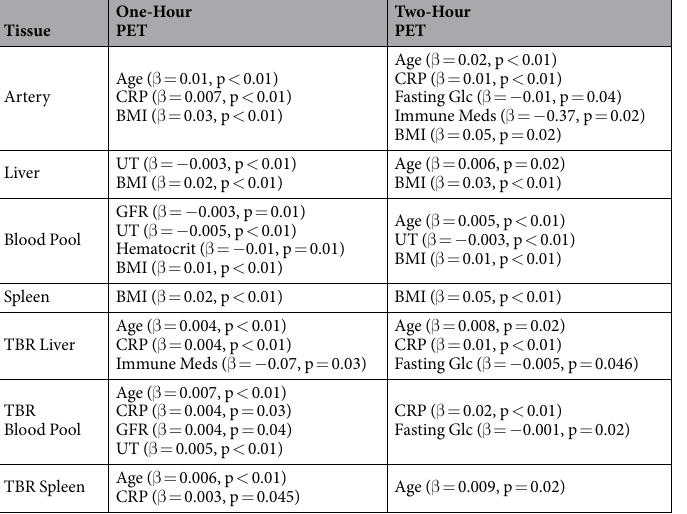
Table 4. Summary of Clinical Factors Associated with FDG Distribution at One and Two-Hour Imaging Time Points. * The following variables were included in each regression model: sex (female), body mass index (BMI), age in years, C-reactive protein (CRP, mg/L), total white blood cell count (WBC, 10 9 /L), treatment with immunosuppressant medications other than glucocorticoids (Immune Meds, Yes vs No), daily prednisone dose (mg), physician global assessment (PGA, 0–10 scale), hematocrit (%), uptake time (UT, minutes from injection of FDG), glomerular filtration rate (GFR, mL/min per 1.73 m 2 ), fasting glucose (Fasting Glc, mg/dL). TBR, target-to-background ratio with artery target